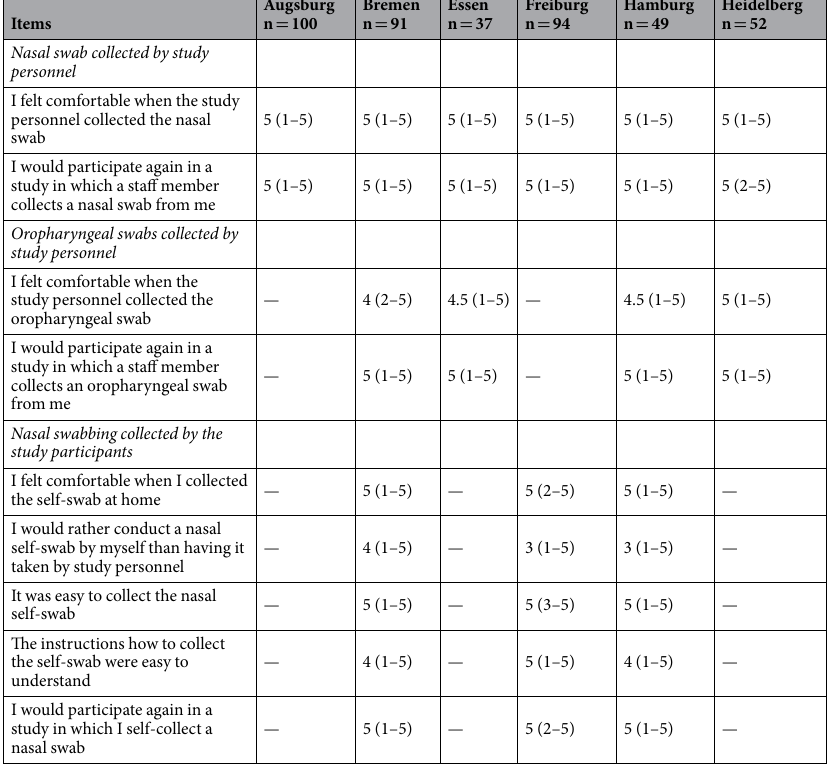
Table 2. Participants’ acceptance of nasal and oropharyngeal swabbing at the study center (median and range). A 5-point Likert scale was used; 1 = strong disagreement, 2 = disagreement, 3 = neither agreement nor disagreement, 4 = agreement, and 5 = strong agreement.